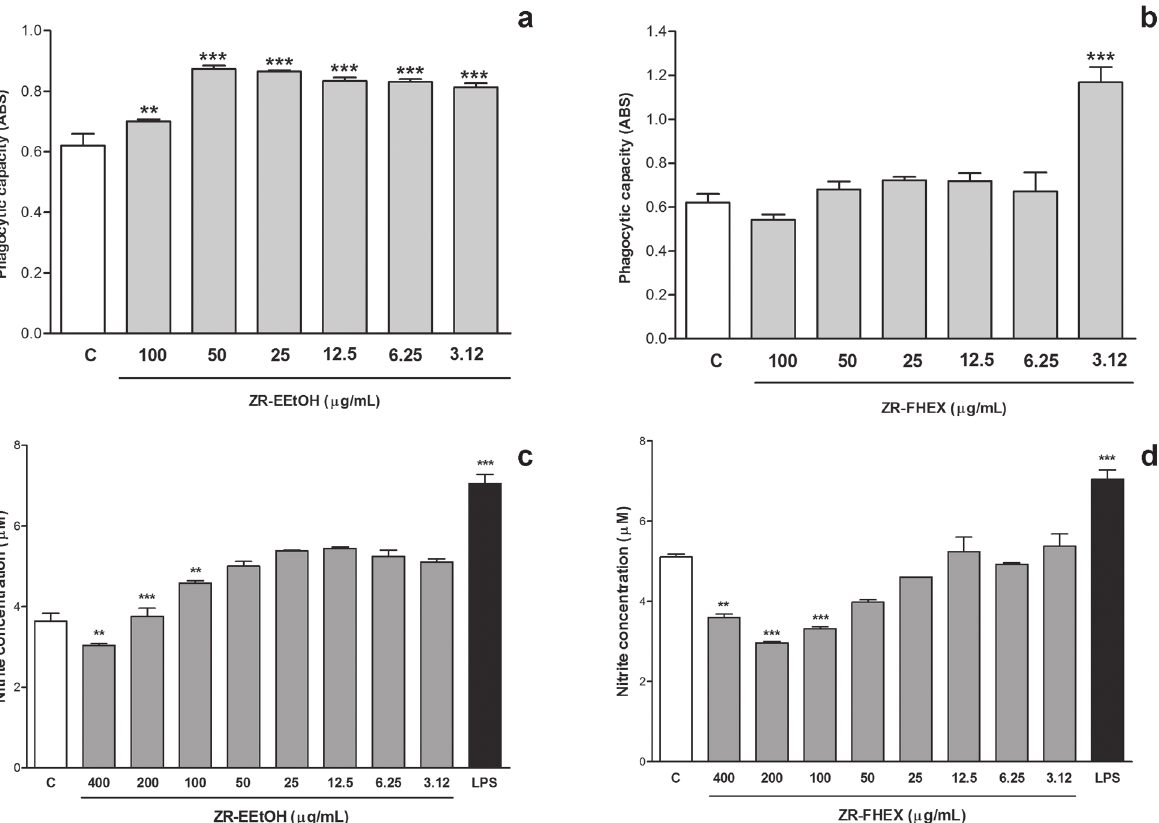
Figure 3 - Phagocytosis of zymosan particles ( a and b ) and Colorimetric measurement of nitrite ( c and d ) produced by macrophages pretreated with ZR-EEtOH or ZR-FHEX. Values are expressed as mean absorbance  s.e.m at 550 nm. One-way ANOVA followed